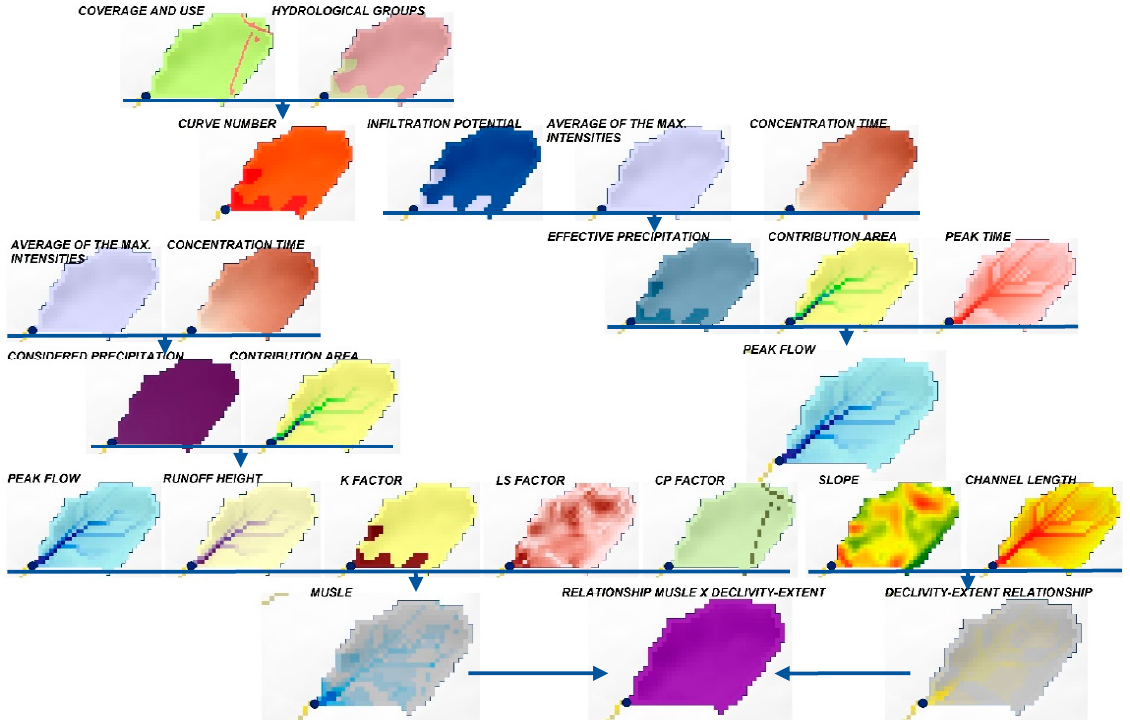
Figure 2. Sequential and logical flowchart of the methodological steps adopted in the development of this article.